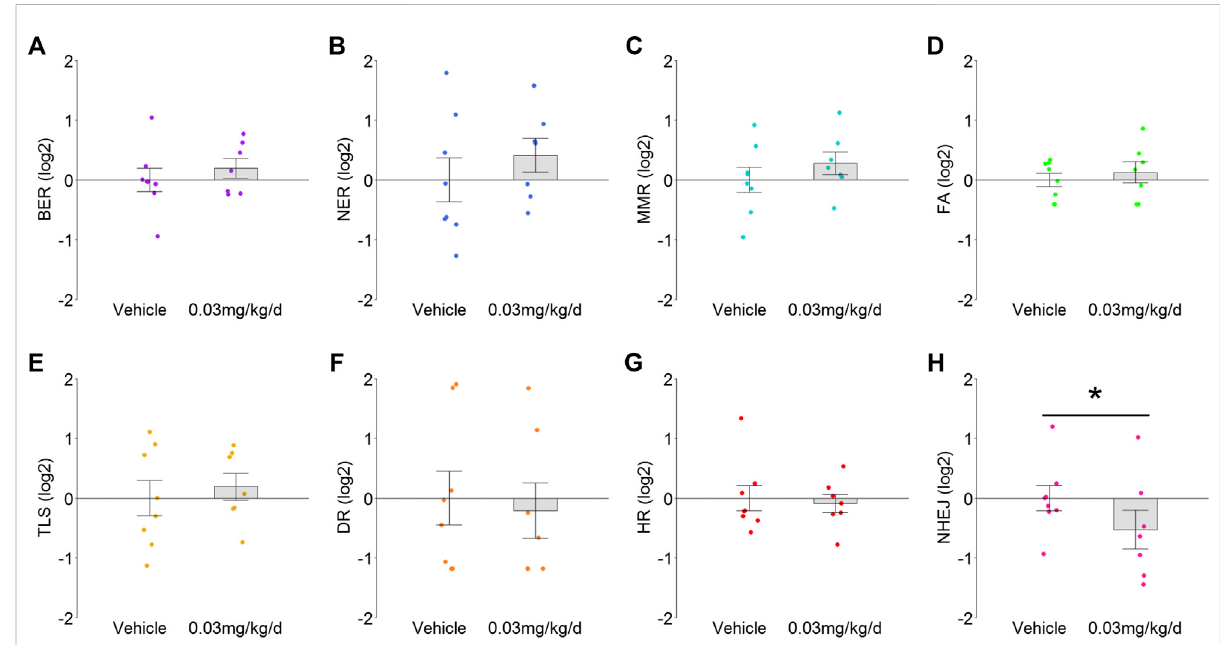
FIGURE 3 TRA for DNA damage response pathways in mammary tissue after BDE-47 administration for (A) base excision repair (BER), (B) nucleotide excision repair (NER), (C) mismatch repair (MMR), (D) Fanconi anemia (FA), (E) translesion DNA synthesis (TLS), (F) direct damage reversal/repair (DR), (G) homology dependent recombination (HR), and (H) non-homologous end joining (NHEJ). Mean ± SEM with overlay of individual TRA composite scoredatapoints,scoresonlog2scalecenteredatzero, n =7-8micepergroup.Seetextforreferenceforgenesets.Completelistsforde fi ning genes for each transcriptome are listed in Supplementary Data S3. * p <